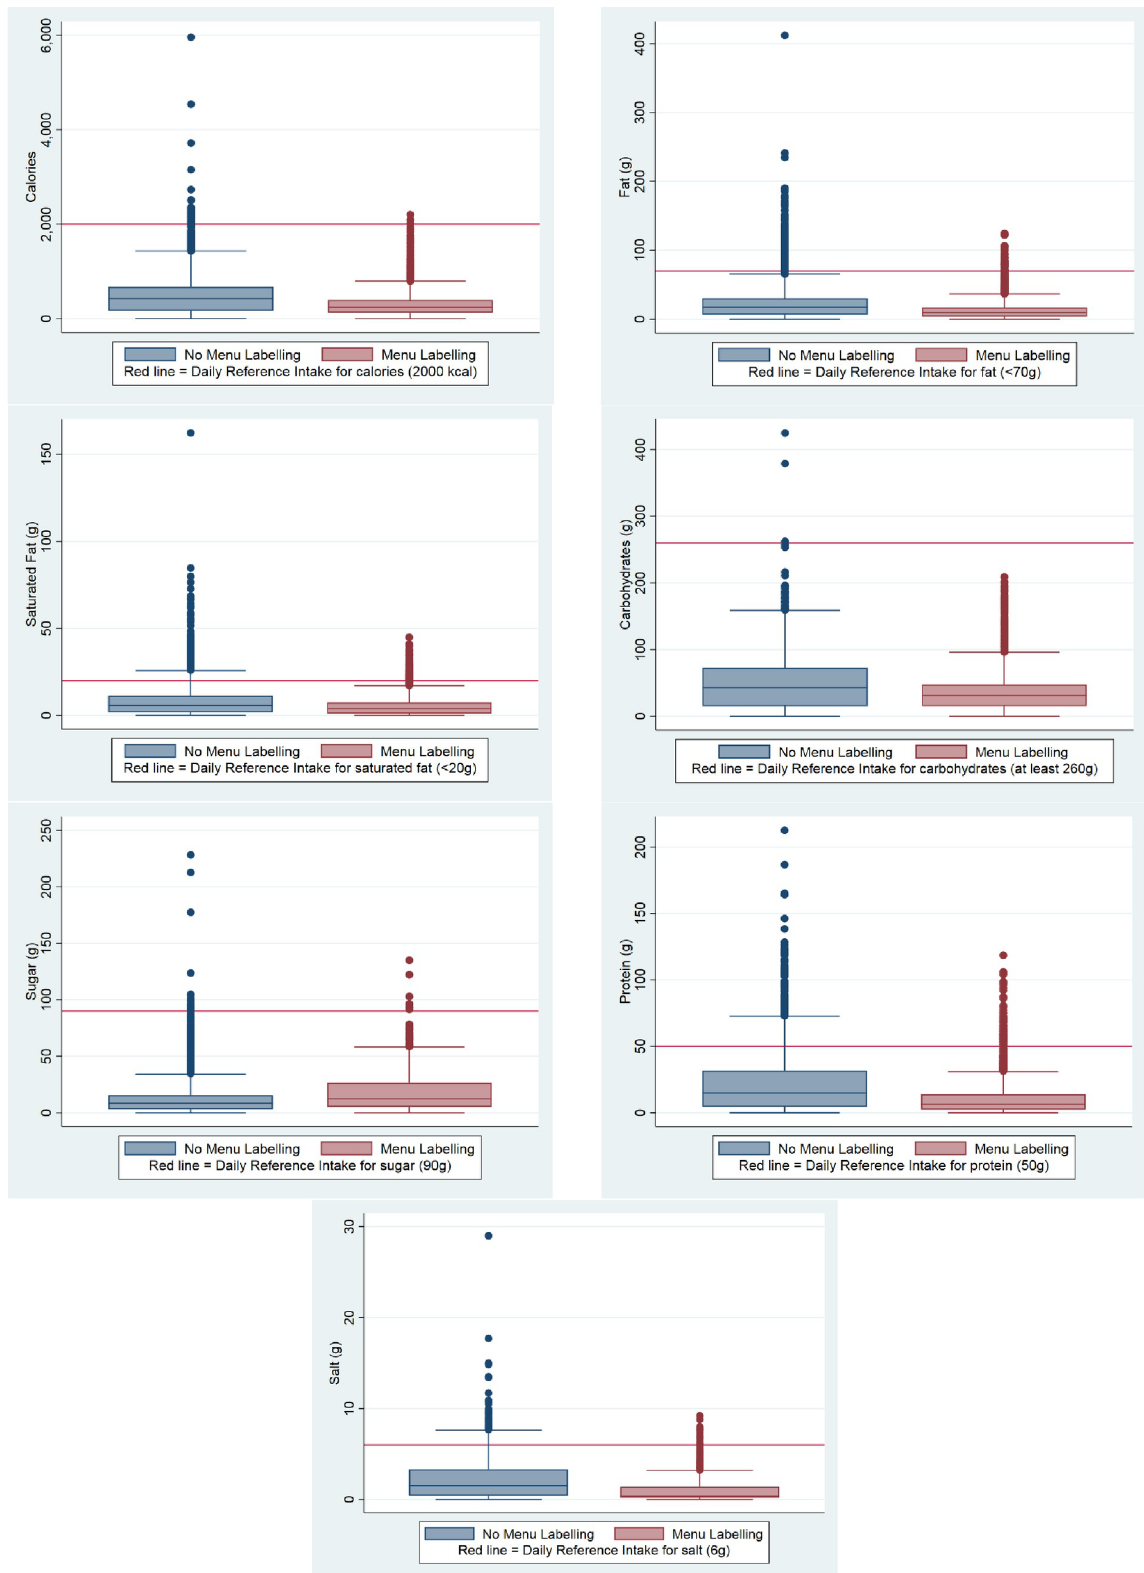
Fig 1. Distribution of energy and nutrients in 9605 menu items from 42 popular UK chain restaurants, stratified by whether or not restaurants provided voluntary menu labelling. https://doi.org/10.1371/journal.pone.0222773.g001 PLOS ONE | https://doi.org/10.1371/journal.pone.0222773 October 16,